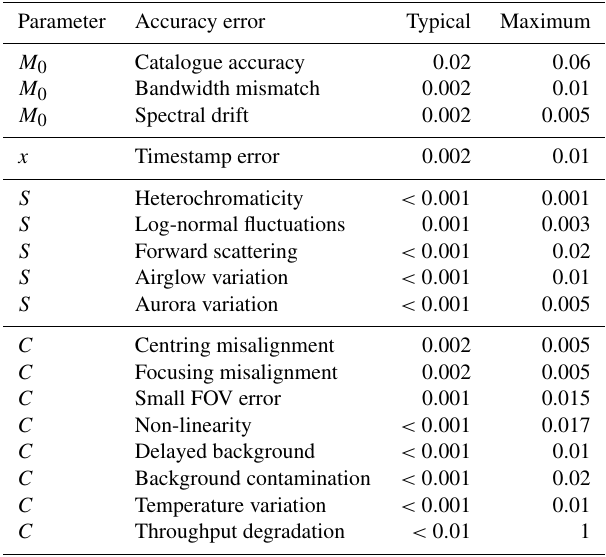
Table 3. Summary of accuracy error sources that would propagate in the τ retrieval, their typical values, and estimates of their upper limits. Water vapour channels were not